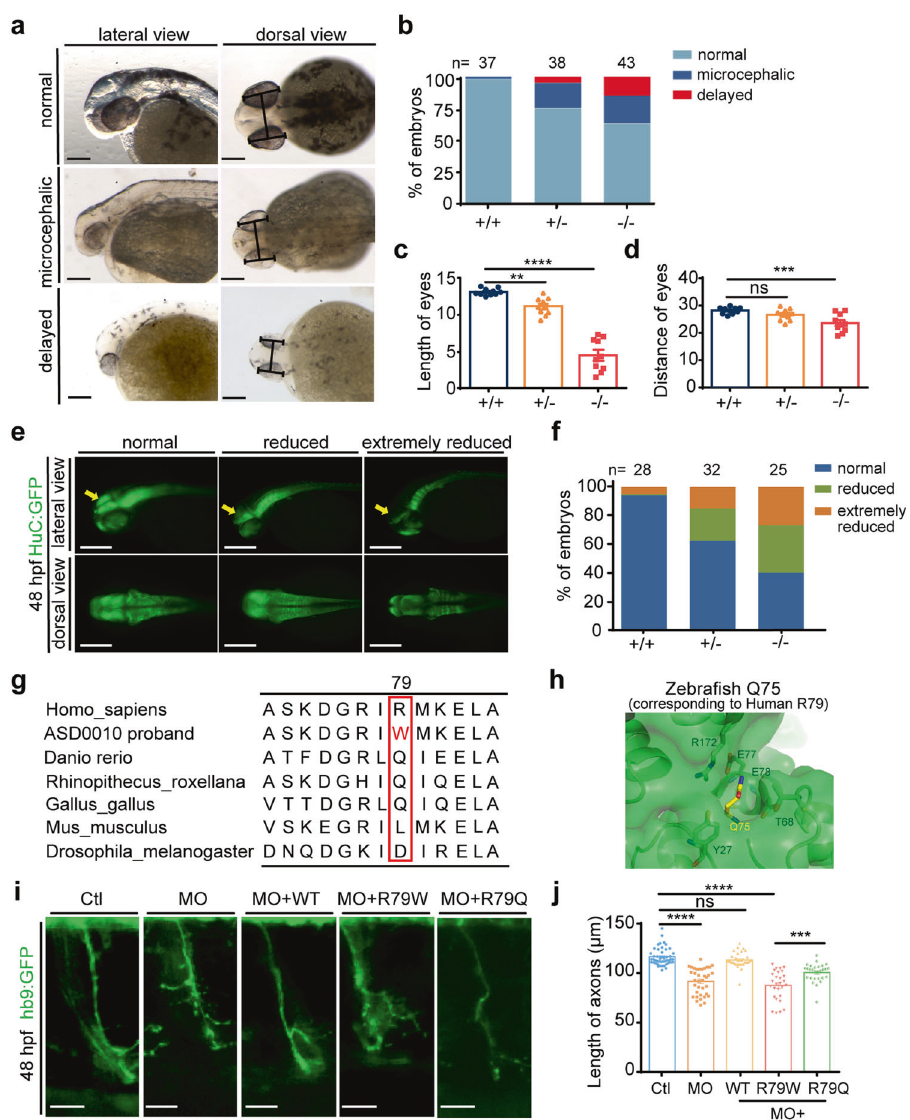
Fig. 3 Scgn de fi ciency impairs neuronal development, and R79W mutation is functionally impaired. a Bright- fi eld images of zebra fi sh embryos classi fi ed in three groups based on head and body morphology at 48 hpf (hours post fertilization). Microcephalic: the brain size is moderately reduced; delayed: fi sh development is severely delayed, and the brain size is signi fi cantly reduced. Scale bar, 100 μ m. b Percentage of embryos in each group as de fi ned in A. N stands for the number of embryos examined from three independent experiments. + / + : scgn + / + ; + / − : scgn + / − ; − / − : scgn − / − . c Relative length of eyes of embryos at 48 hpf. Experiments were repeated three times. **** p < 0.0001, ** p < 0.01. P -values were calculated using one-way ANOVA, Tukey ’ s multiple comparisons test. d Relative distance between a pair of eyes of embryos at 48 hpf. Experiments were repeated three times. *** p < 0.001, ns not signi fi cant. P -values were calculated using one-way ANOVA, Tukey ’ s multiple comparisons test. e Classi fi cation of zebra fi sh embryos based on the expression level of HuC (elavl3) at 48 hpf. Reduce: the brain size is moderately decreased; Extremely reduced, the brain size is signi fi cantly reduced.(Top) Lateral views; (Bottom) dorsal views. f Percentage of embryos in each group as de fi ned in E. N stands for the number of embryos used for statistical analysis. All experiments were performed in three repetitions. g Multispecies alignment of SCGN protein sequences, Sequence of the ASD0010 proband is included as a comparison. h Detailed view of zebra fi sh SCGN Q75 (yellow stick, equivalent to human R79) and its surrounding residues (PDB:6JLH). Residues located within 4 Å of Q75 are shown in stick representation. i Hb9 (green) expression in Tg [Hb9: GFP] transgenic zebra fi sh. Enlarged views are shown. Ctl: control MO injection; MO: scgn MO injection; MO + WT: co-injection of scgn MO and wide-type human scgn mRNA; MO + R79W: